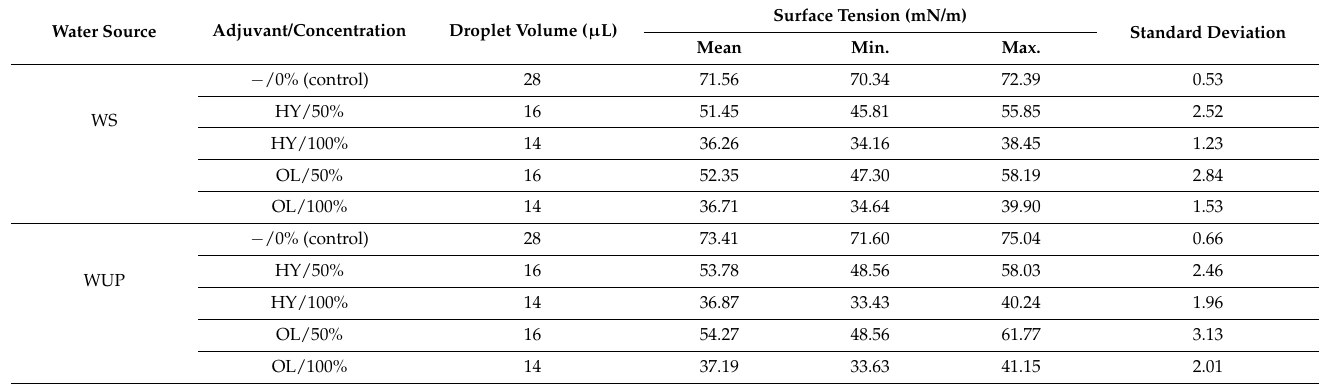
Table 4. Effect of water type, adjuvant type, and concentration on the surface tension.